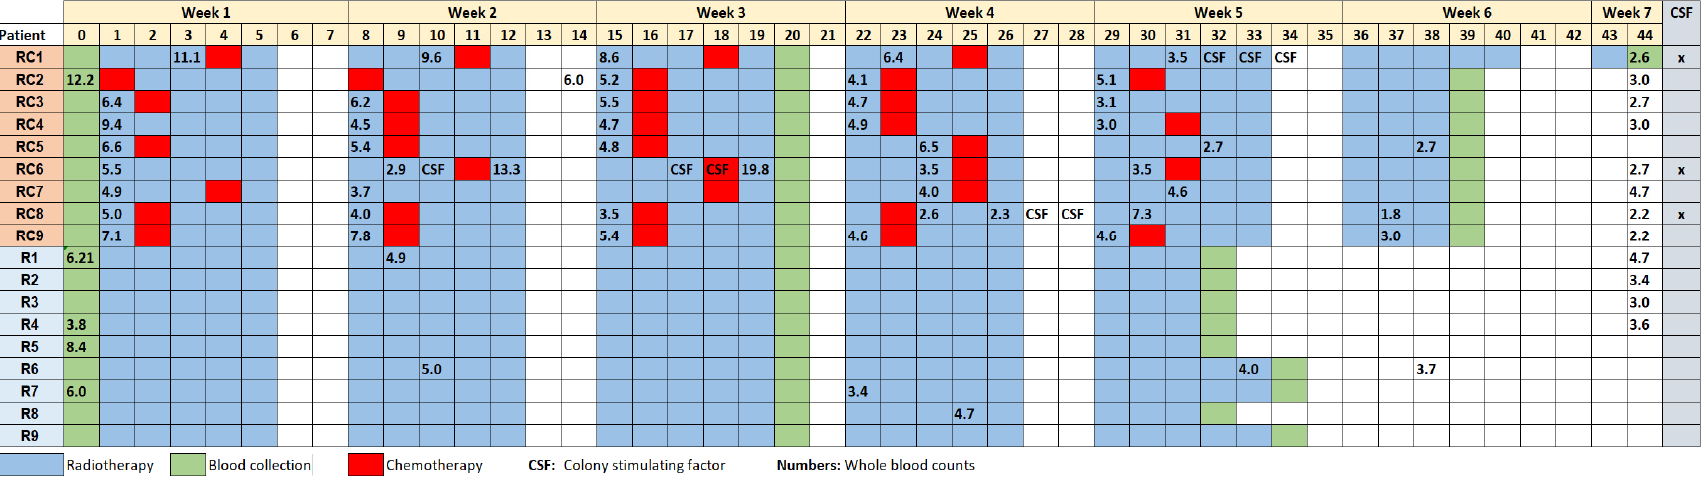
Figure 1. Timeline of treatment and blood collection. Blue and red boxes represent treatments, green boxes represent blood collection. Numbers 0–44 represent days of treatment. Chemotherapy was always given concomitantly to radiotherapy. One row represents one patient. Numbers in the patient rows represent white blood cell counts in 10 9 /L.